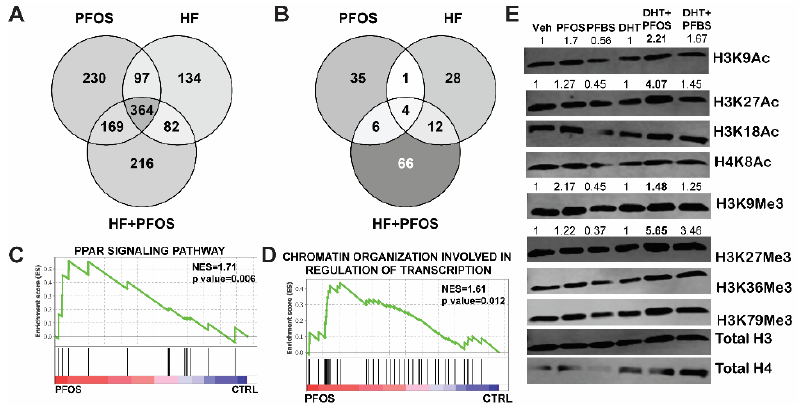
Figure 4. Venn diagram analysis of up- ( A ) or downregulated ( B ) genes in different treatment groups compared to the control group. ( C ). RNA-seq data indicate that PFAS exposure combined with a high-fat diet increased PPAR signaling in RWPE-kRAS xenografts. ( D ). RNA-seq data also indicated epigenetic regulation of transcription-associated genes in RWPE-kRAS xenografts. ( E ). Western blots demonstrating PFAS exposure increased histone acetyl markers in RWPE-kRAS cells. Numbers above bands indicate quantitation of signal for marks in samples that are treated with DHT+PFAS that change over DHT treatments.